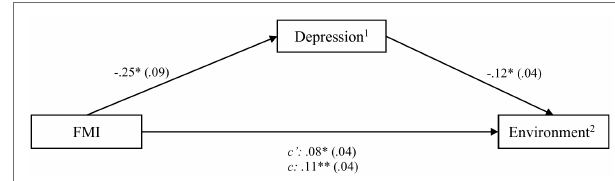
FIGURE 4 | Process outcomes including FMI and environmental quality of life. * p < 0.05; ** p < 0.01, 1 assessed by the DASS, 2 assessed by the